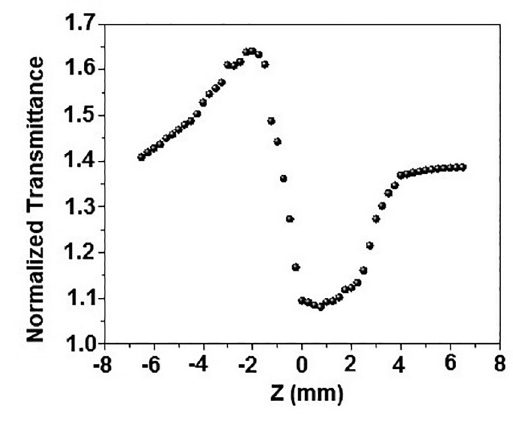
Figure 9: Z-scan close curvature of the